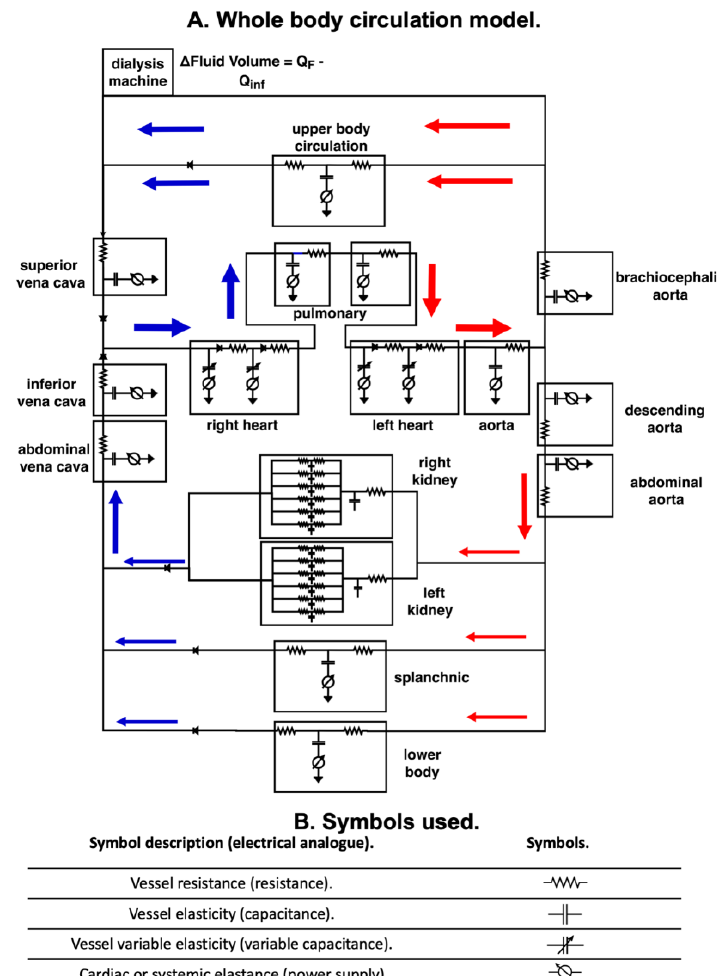
Figure 2. Schematic of presented model. ( A ) Electrical circuit analogue of the reduced order whole body human circulation model. Arrows represent direction of blood flow in arteries (red) and veins (blue). The hemodynamic symbols and their electrical analogues are shown at the bottom of the figure in panel ( B ). Symbols used in panel ( A ). Acronyms: Q f : ultrafiltration rate. Q inf : injecting flow rate of the dialyser fluid.